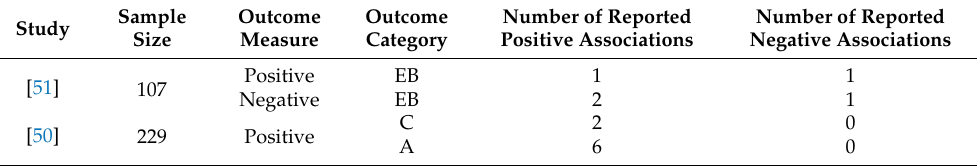
Table 8. Structured and semi-structured play—outcome measure descriptions and results